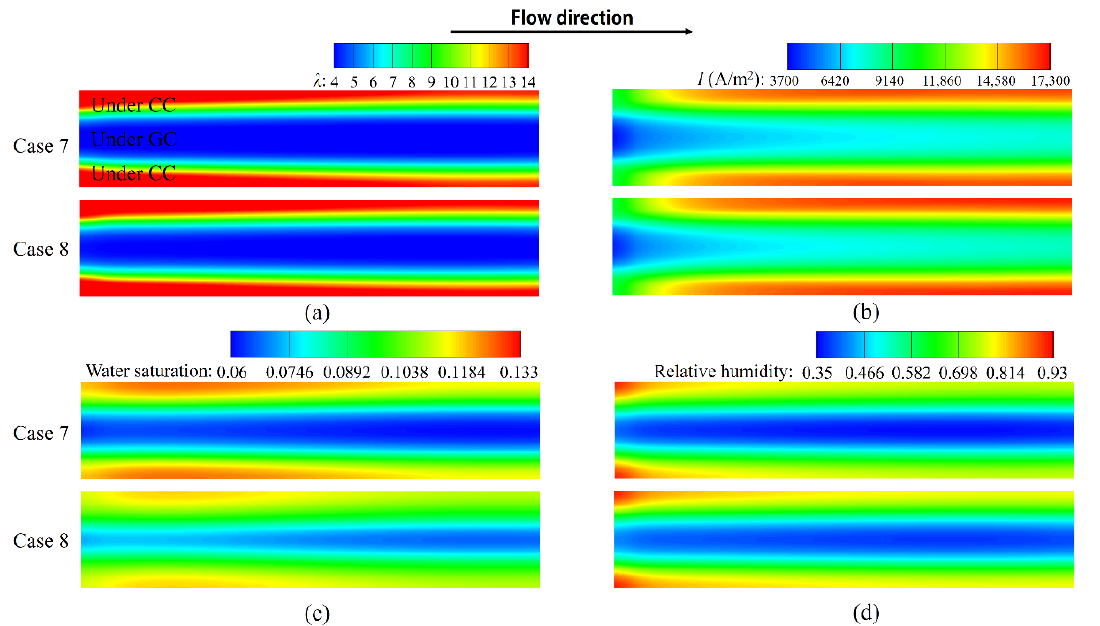
Figure 8. Comparison of key variable distribution in Cases 7–8 with GDL of sandwich PTFE doping: ( a ) oxygen concentration ( b ) temperature, ( c ) dissolved water content and ( d ) current density distribution in the middle plane of CCL.